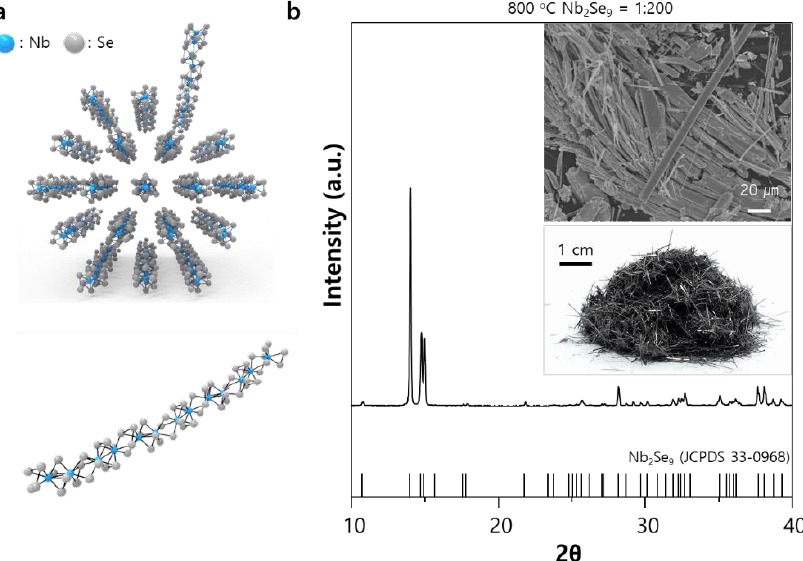
Figure 1. ( a ) Schematic illustration of the crystal structure and exfoliation process of Nb 2 Se 9 ; ( b ) X-ray diffraction (XRD) pattern of Nb 2 Se 9 crystals (inset shows the scanning electron microscopy (SEM) of Nb 2 Se 9 crystals (left) and STEM image of the exfoliated Nb 2 Se 9 (right)).